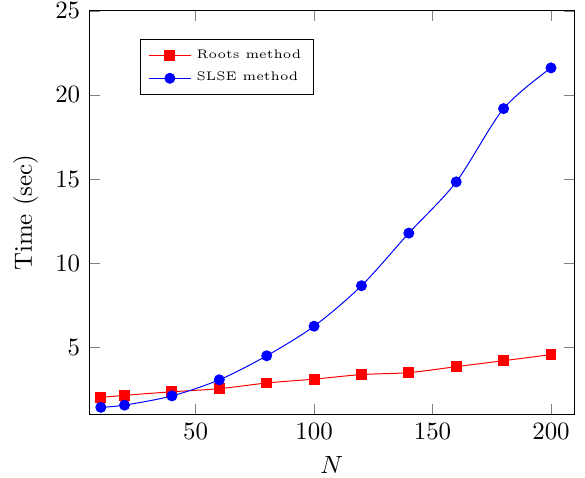
Figure 2. Time (in seconds) needed to calculate post-departure